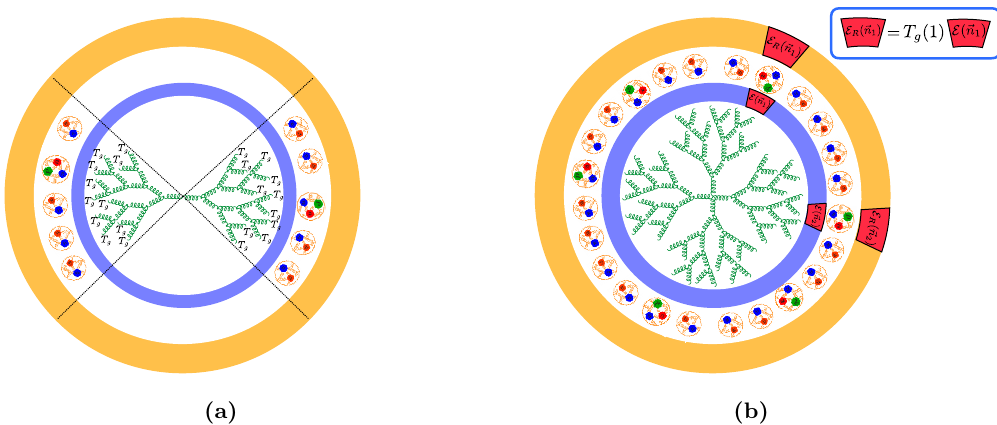
Figure 1. (a) For a standard dijet event shape observable, which constrains the phase space of all emissions, a separate track function is needed for every emission, leading to a complicated structure of the hadronization process. (b) For energy correlators, matching can be performed at the level of the detectors, instead of for each parton. Since the number of detectors is fixed this leads to a much simpler description of the transition from quarks and gluons to